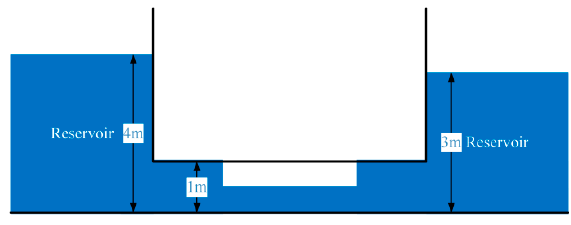
Figure 15. A sketch of the reservoir–conduct–reservoir model.